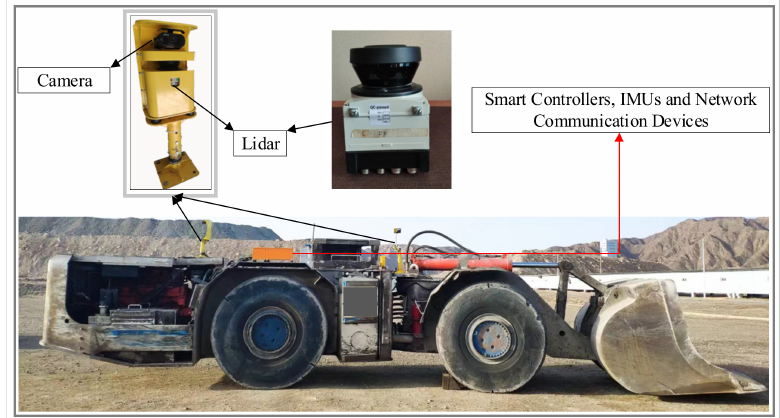
Figure 1. The LHD and sensors layout.